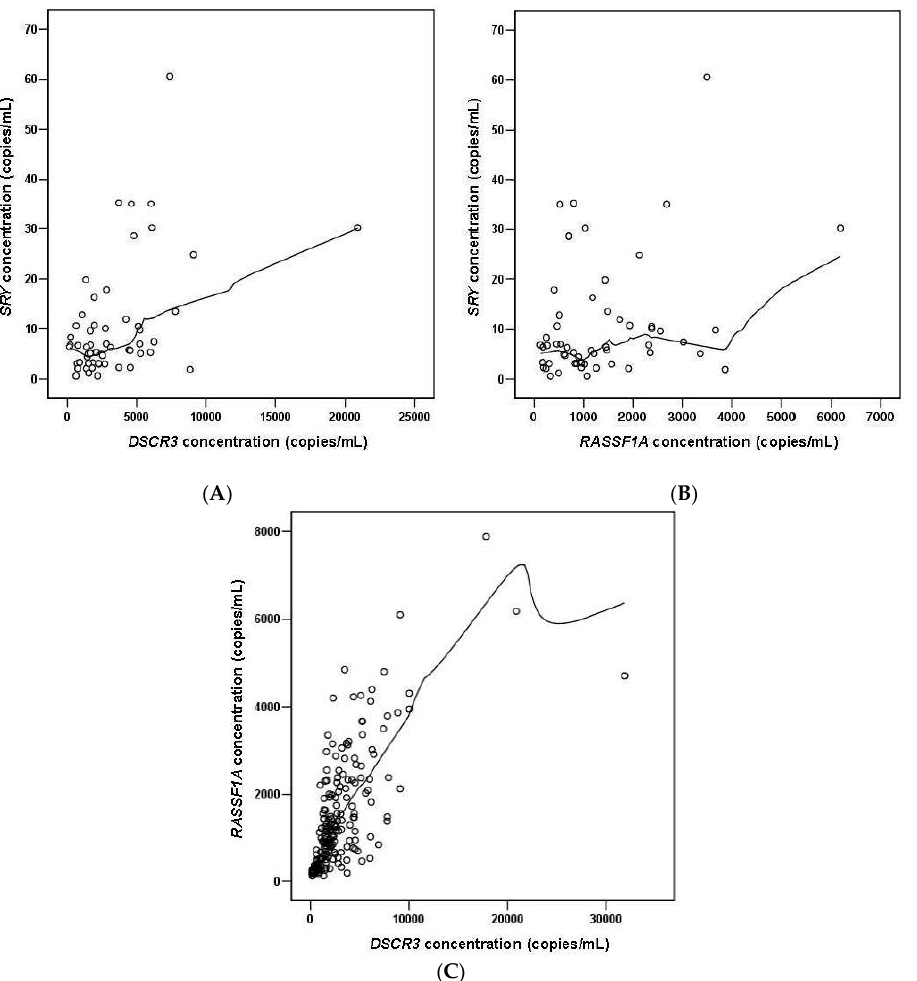
Figure 4. Relationship between ( A ) DSCR3 and SRY, ( B ) RASSF1A and SRY, ( C ) DSCR3 and RASSF1A concentrations in the control group. The solid black lines represent lines of best fit (estimated with Loess regression).